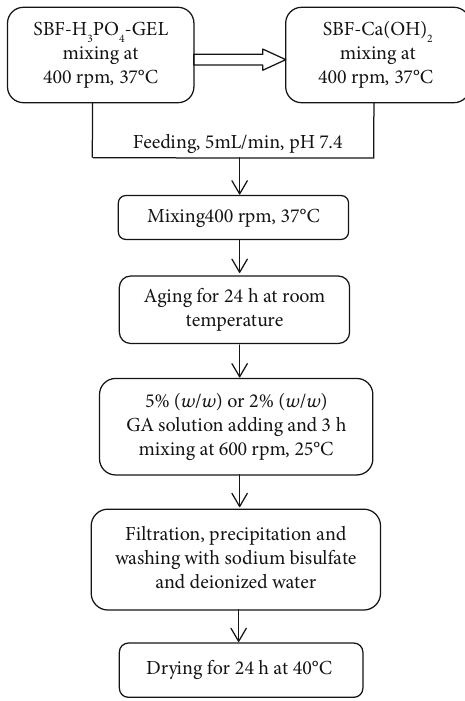
Figure 1: Flowsheet of the production of the HAp-GEL